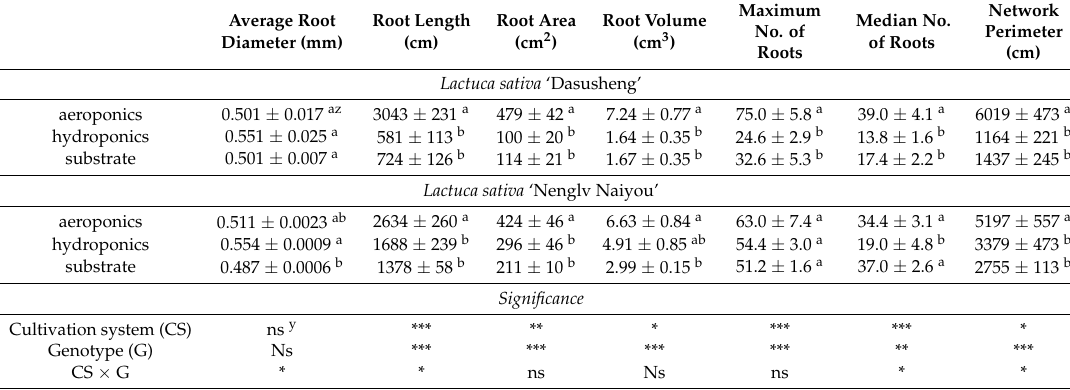
Table 2. Root characteristics of lettuce grown in aeroponics, hydroponics, and substrate culture systems. Average Root Diameter